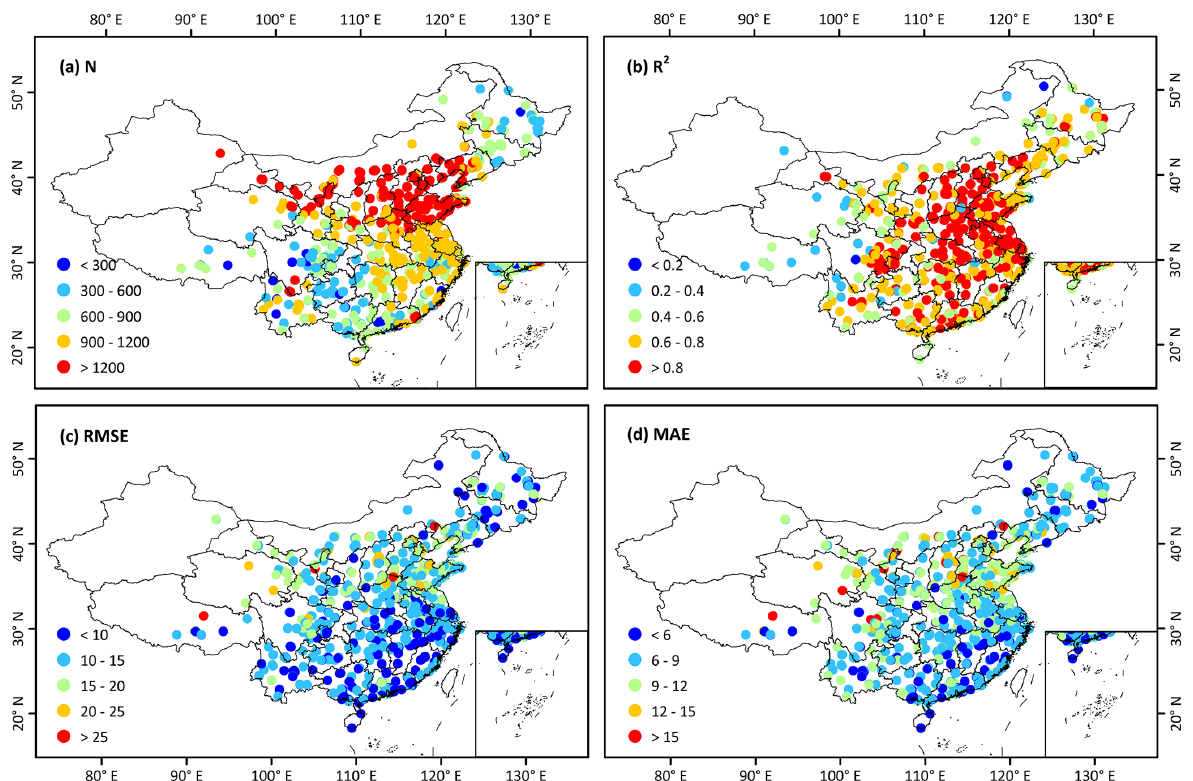
Figure 7. Individual-site-scale validation of hourly PM 2 . 5 estimates (µgm − 3 ) in 2018 in China in terms of (a) the sample size (N), (b) CV- R 2 , (c) RMSE, and (d) MAE.